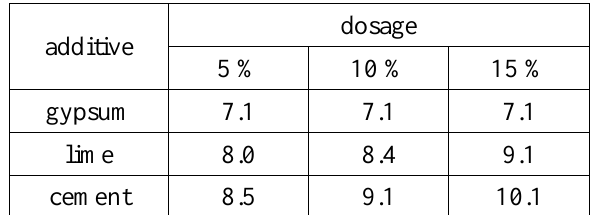
Table 5. Effect of different percentage dosages of chemical additives (gypsum, lime or ordinary Portland cement) on pH value of the stabilised peat.